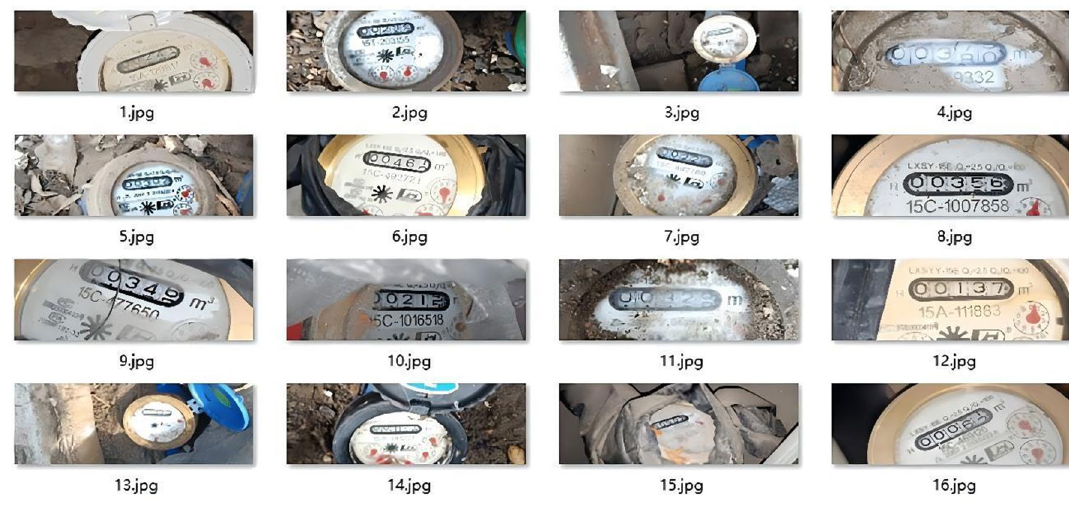
Figure 1. Part of water meter image